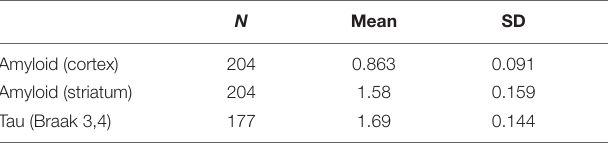
TABLE 1 | Normative values used for z -transformation.